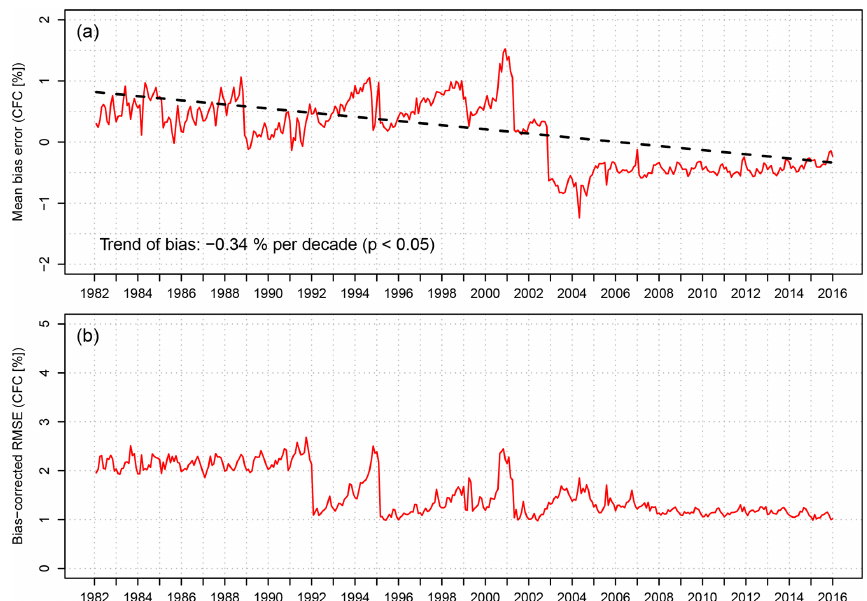
Figure 17. Time series of MBE and bcRMSE caused by orbital drift and discrete sampling of the CFC diurnal cycle presented for AVHRR- like CDR derived from combined morning and afternoon